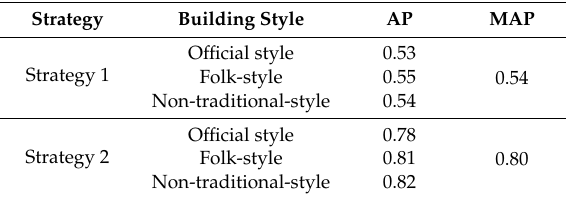
Table 4. Average precision (AP) and mean average precision (MAP) of the TBMask R-CNN model on test dataset.